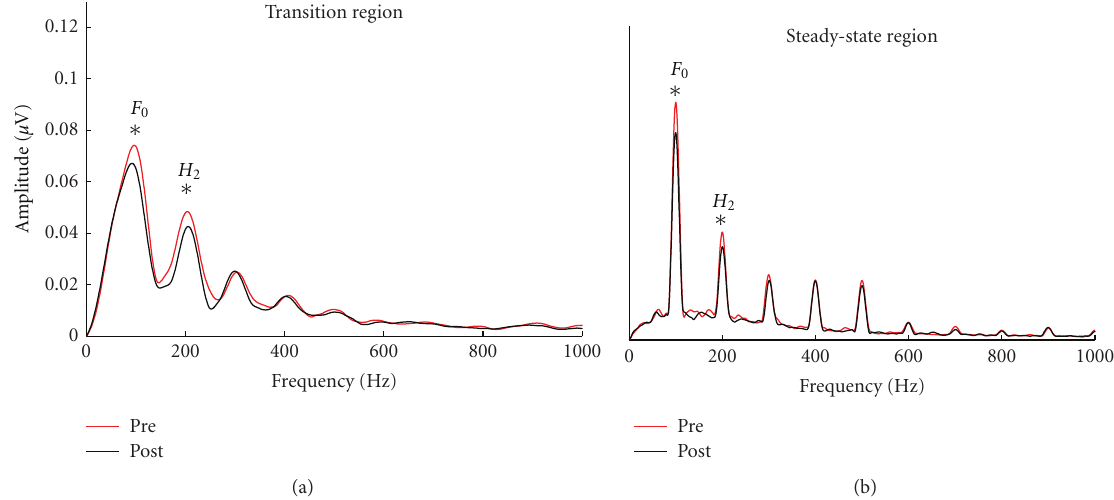
Figure 5: Young adults with normal hearing have greater representation of the 𝐹 0 in subcortical responses to /da/ presented in noise after undergoing LACE auditory training. The 𝐹 0 and the second harmonic have greater amplitudes in the postcondition when calculated over the transition (20–60ms) (b) and the steady state (60–170 ms) (a). Modified from [66].